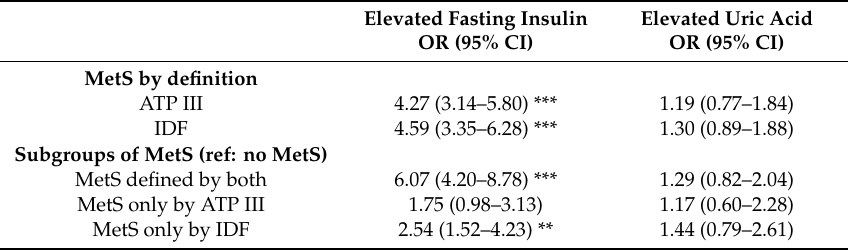
Table 5. Odds ratios and 95% confidence intervals (CI) of CVD / T2DM surrogates for MetS as defined by the ATP III and IDF